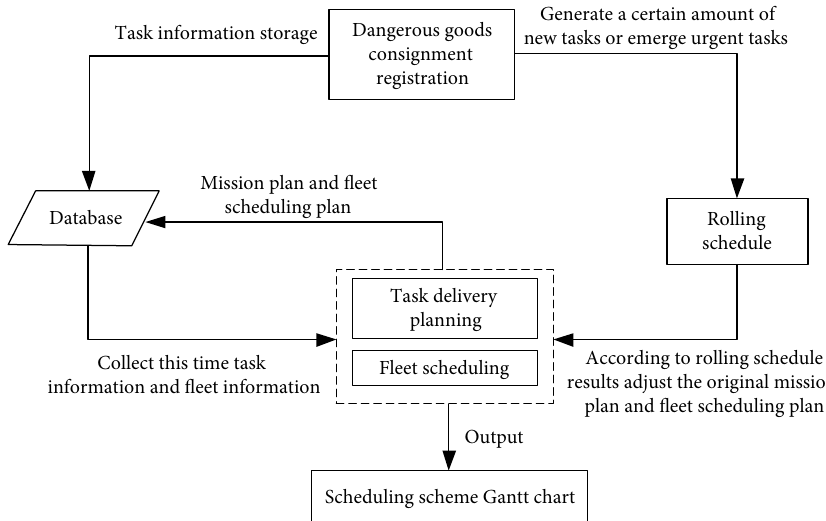
Figure 6: Rolling schedule process for hazardous materials transport